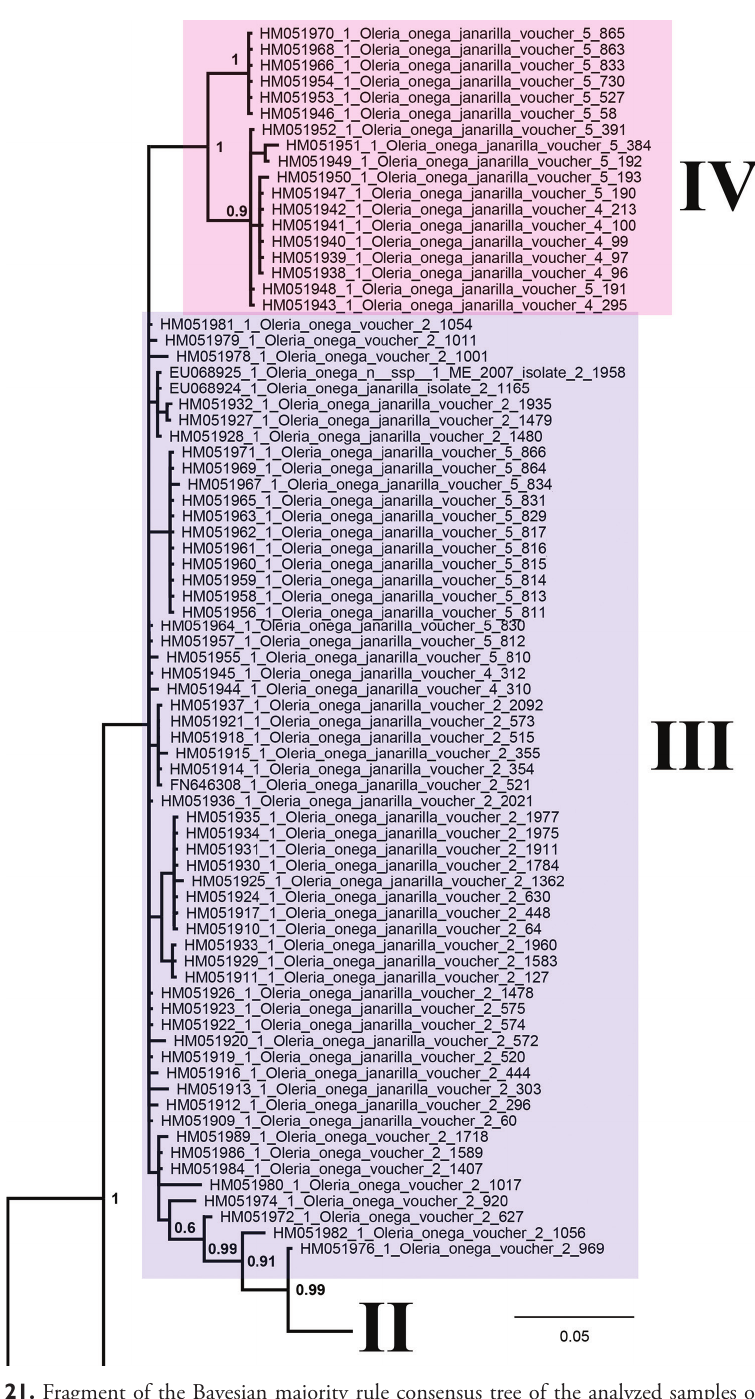
Figure 21. Fragment of the Bayesian majority rule consensus tree of the analyzed samples of Ithomi- ini inferred from COI sequences. The clusters III and IV of the Oleria onega species complex are shown. Bayesian posterior probabilities higher than 0.5 are shown next to the recovered